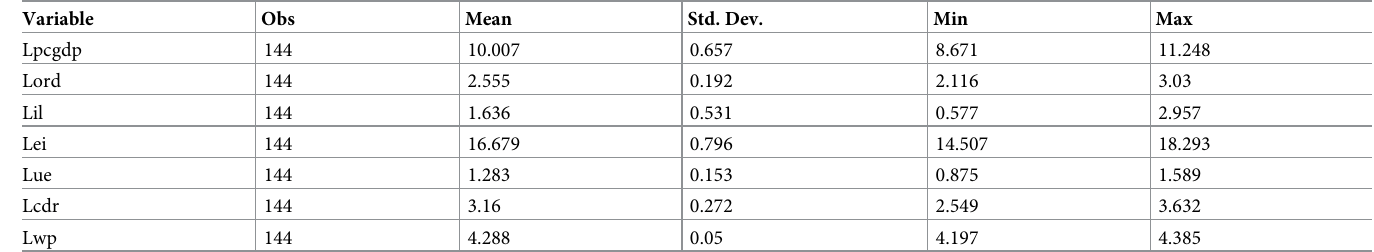
Table 4. Descriptive statistics of central region of China. Variable